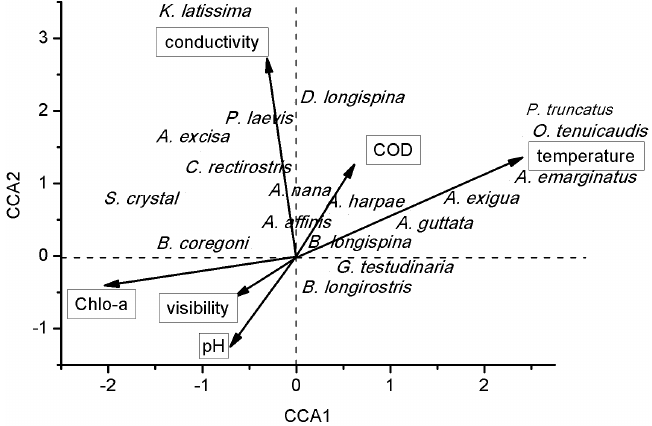
Figure 6. CCA ordination of Cladocera taxa and water chemical